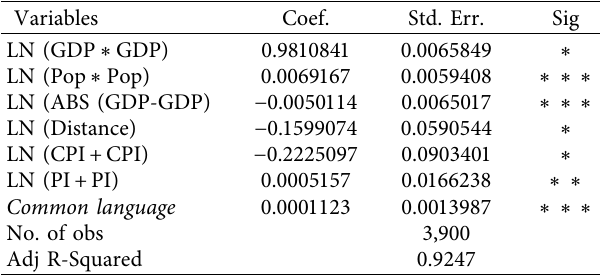
Table 3: Summary coefficients on gravity model